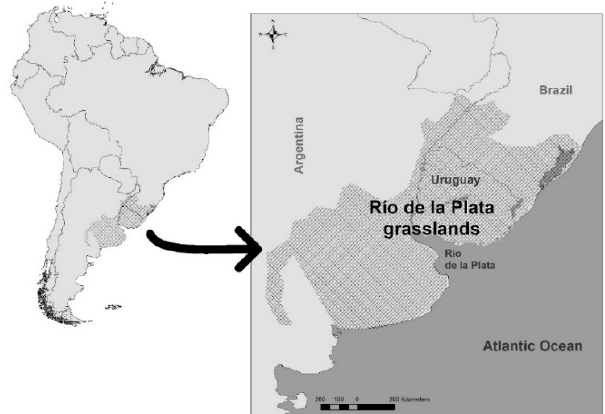
Figure 2. Map of South America highlighting the Río de la Plata grasslands region. Adapted from Miñarro and Bilenca [43].